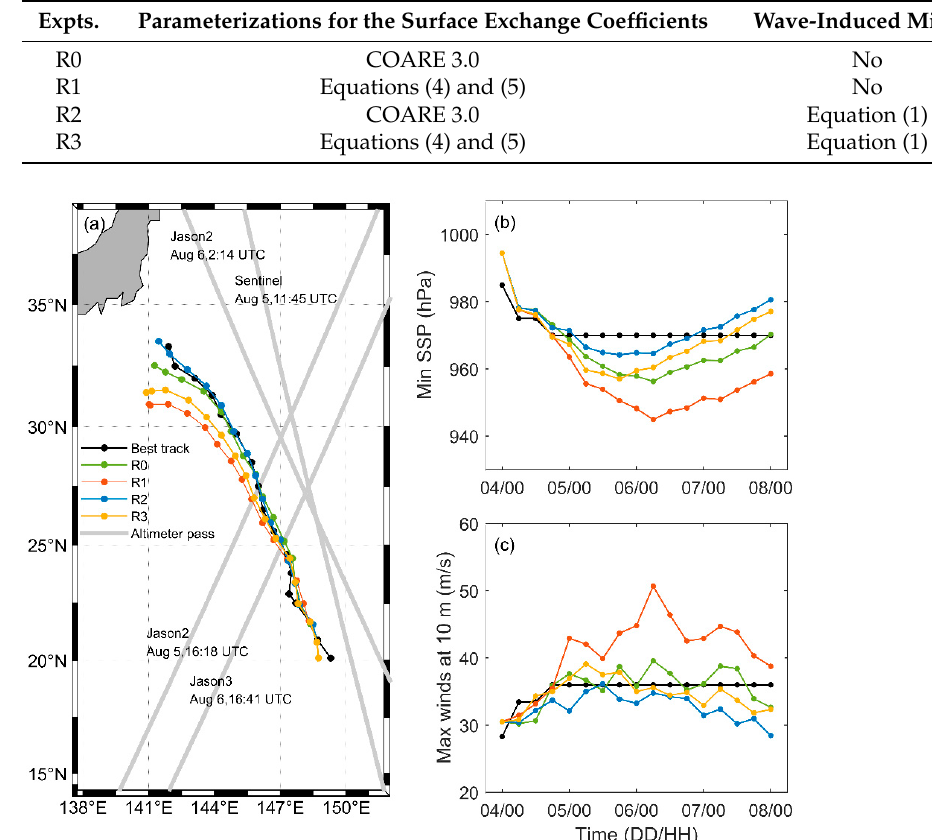
Figure 2. JMA best track data for Shanshan and simulated results from four different numerical experiments at 6-hourly intervals from 00:00 UTC 4 August to 00:00 UTC 8 August 2018. ( a ) Track; ( b ) minimum sea surface pressure; ( c ) maximum wind speed at 10 m. Grey lines in panel ( a ) indicate the ground tracks of altimeters Jason-2, -3, and Sentinel during the period covered in the Shanshan simulations. See Table 1 for details of the different numerical experiments.